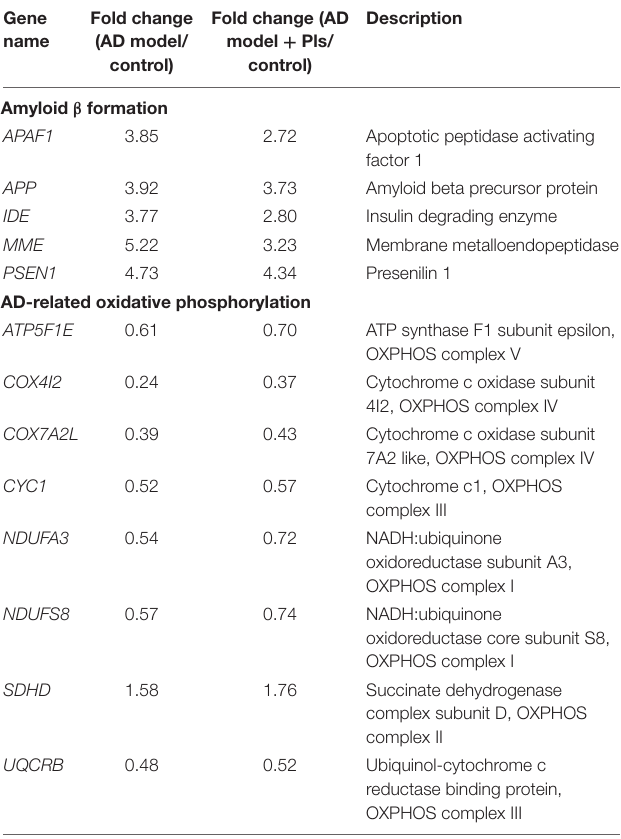
TABLE 2 | List of the significant ( p < 0.05) AD-associated DEGs and respective fold changes identified among different groups.